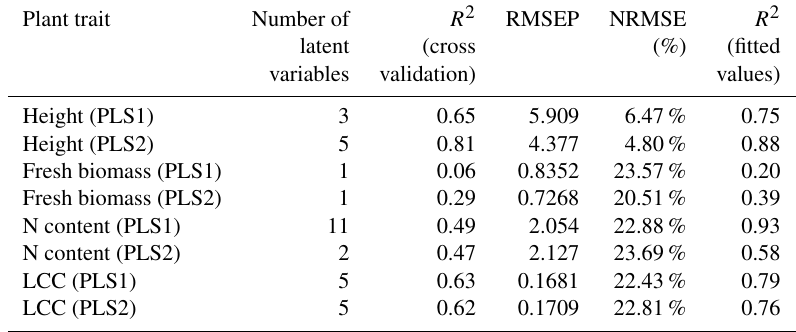
Table 6. Statistical parameters of the PLS model calibration for the four selected plant traits. LCC: leaf chlorophyll content. Plant